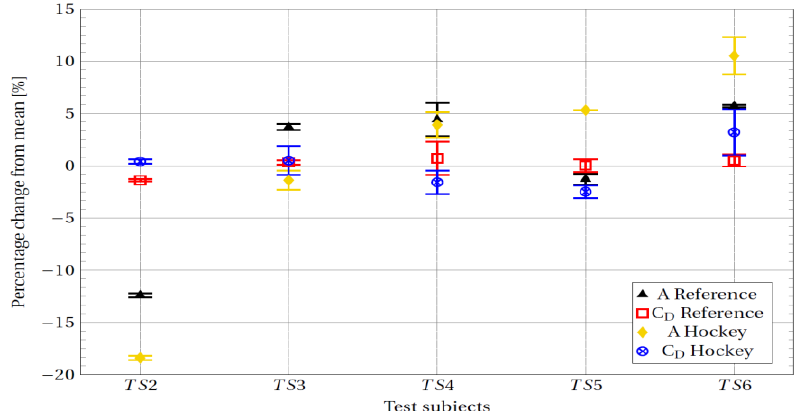
Figure 5. Percentage difference of the frontal area and drag coefficient in reference and in hockey position, relative to the mean value, for five different test